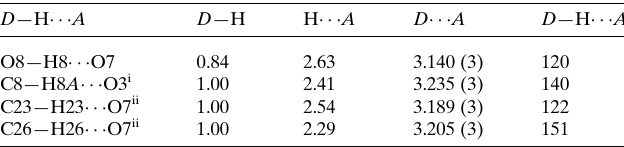
Table 1 Hydrogen-bond geometry (A˚ , (cid:6) ).